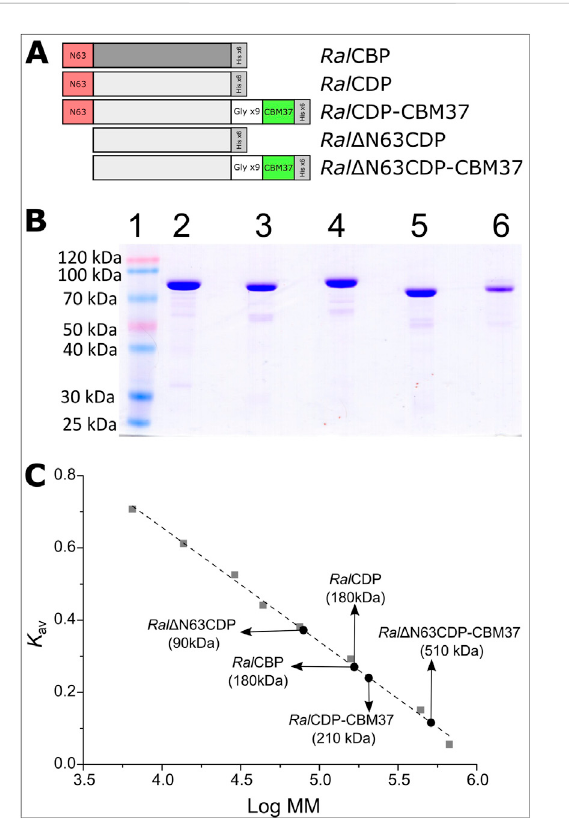
FIGURE 3 Schematic representation of CDP variants (A) . SDS-Page of puri fi ed proteins: Molecular mass marker (1), Ral CBP (2), Ral CDP (3), Ral CDP-CBM37 (4), Ral Δ N63CDP (5)and Ral Δ N63CDP-CBM37(6) (B) . Quaternary structure determination for each enzyme variant by size exclusion chromatography